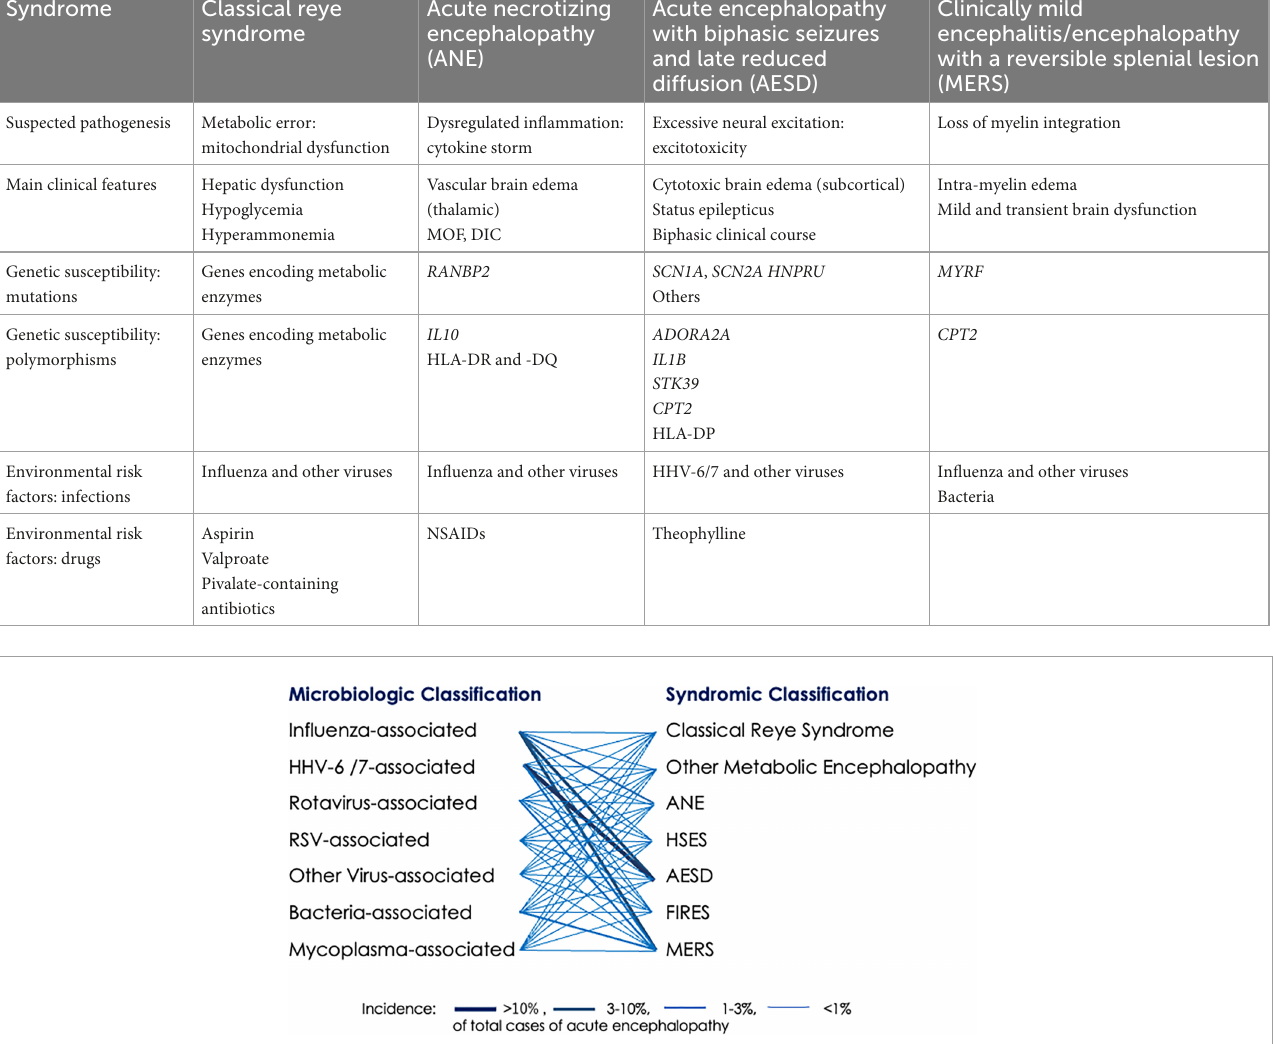
FIGURE1 Association between pathogens of antecedent infection and encephalopathy syndromes. A bold line indicates high incidence, based on epidemiologic data in Japan (Hoshino et al., 2012; Kasai et al., 2020). ANE, acute necrotizing encephalopathy; AESD, acute encephalopathy with biphasic seizures and late reduced diffusion; FIRES, febrile infection-related epilepsy syndrome; HHV, human herpesvirus; HSES, hemorrhagic shock and encephalopathy syndrome; MERS, clinically mild encephalitis/encephalopathy with reversible splenial lesion; RSV, respiratory syncytial